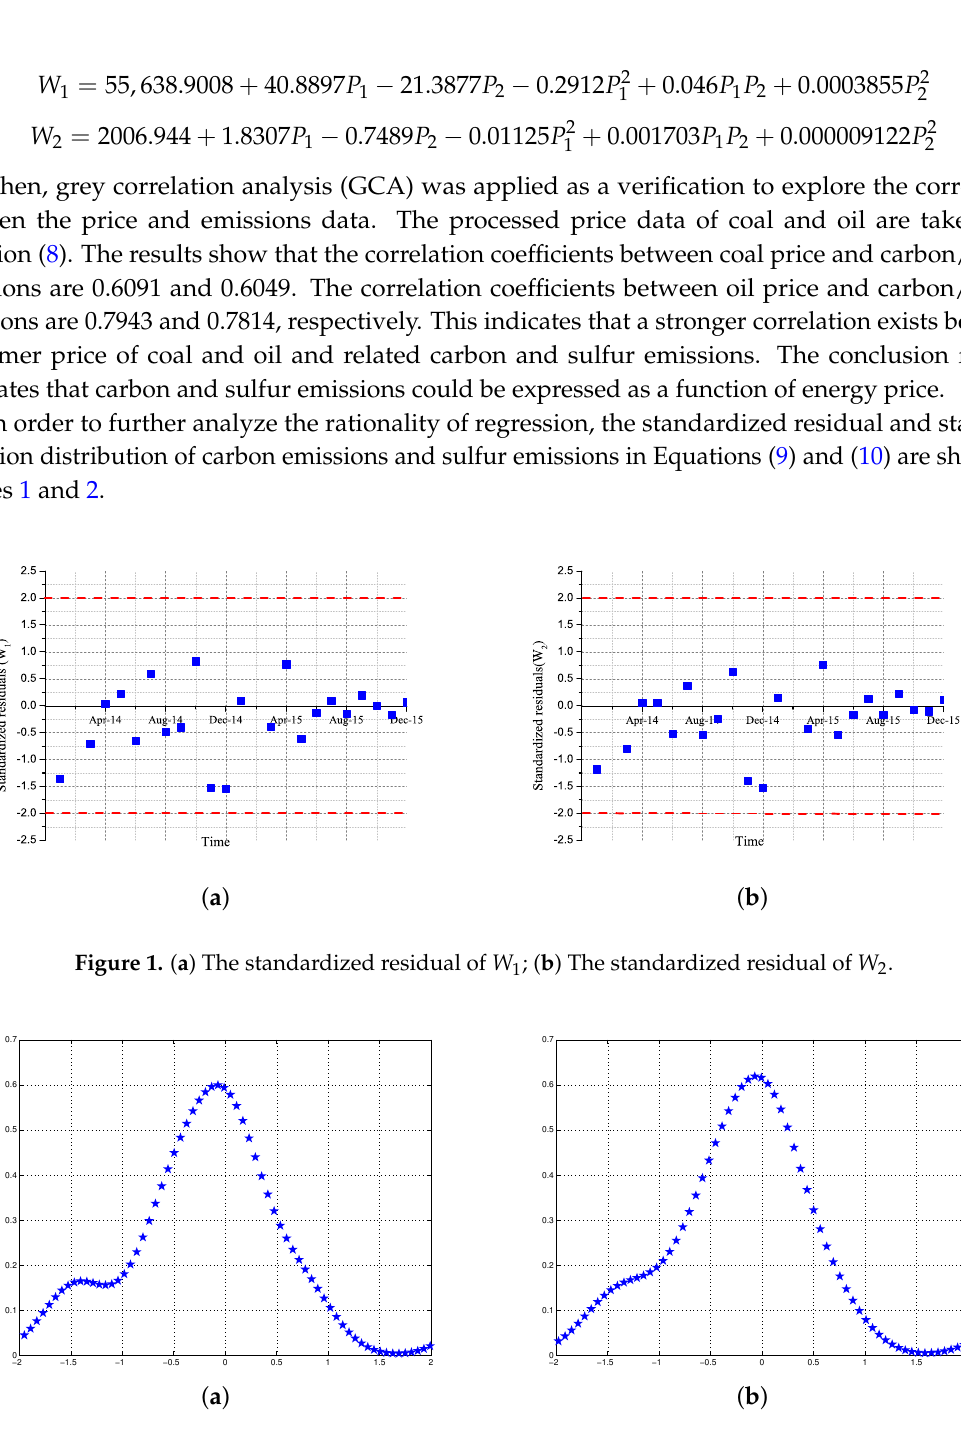
Figure 2. ( a ) The standard deviation distribution of W 1 in Equation (9); ( b ) The standard deviation distribution of W 2 in Equation